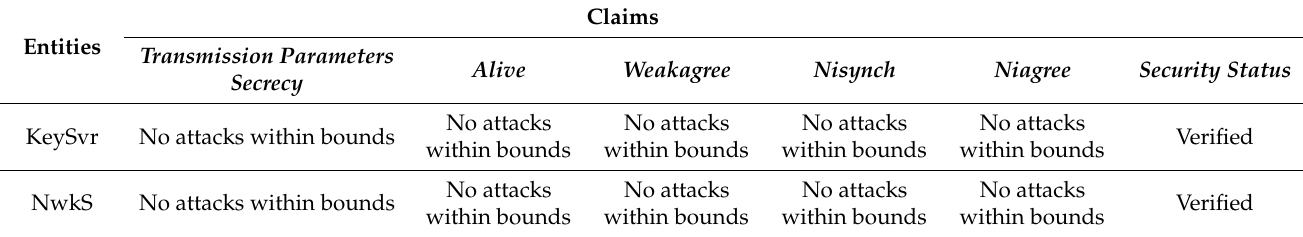
Table 3. KeySvr and NwkS security